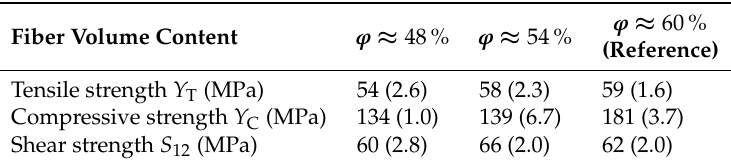
Figure 11. Gapping samples—tensile and compressive strength in transverse direction Y T ( a ) and Y C ( b ); and shear strength S 12 ( c ) from V-notch rail shear tests according to ASTM 7078 at different fiber volume contents. Table 11. Samples with gaps—resulting material strength properties: from maximal gap width ( ϕ ≈ 48%) to initial state ( ϕ ≈ 60%).